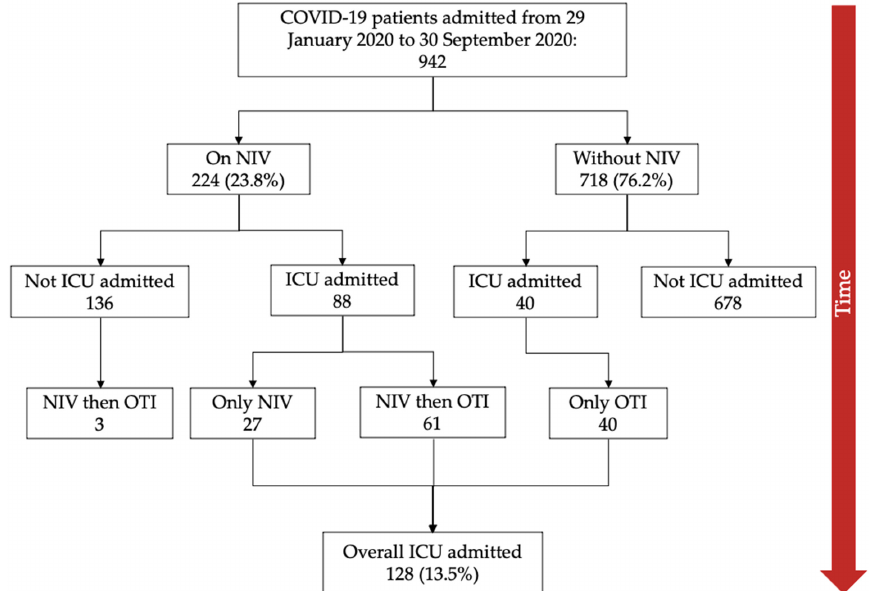
Figure 1. Flowchart of study selection. Abbreviations: COVID-19, coronavirus disease 2019; NIV, noninvasive ventilation; ICU, intensive care unit; OTI, orotracheal intubation. Table 1. Baseline demographics and clinical features of COVID-19